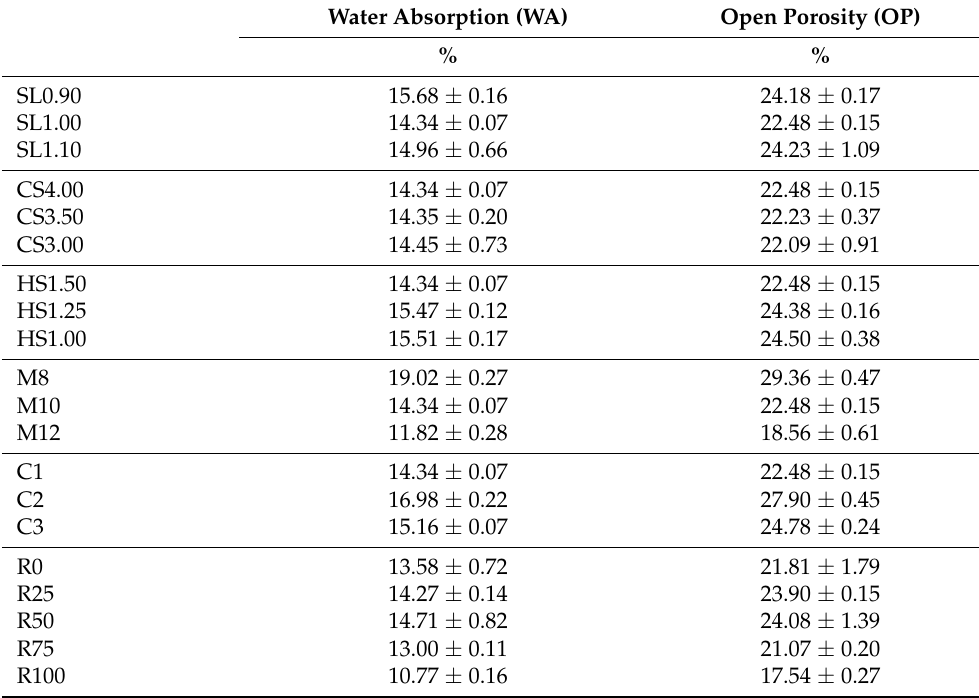
Table 5. The water absorption and open porosity of the alkali activated binders after 28 days of curing. Water Absorption (WA) Open Porosity